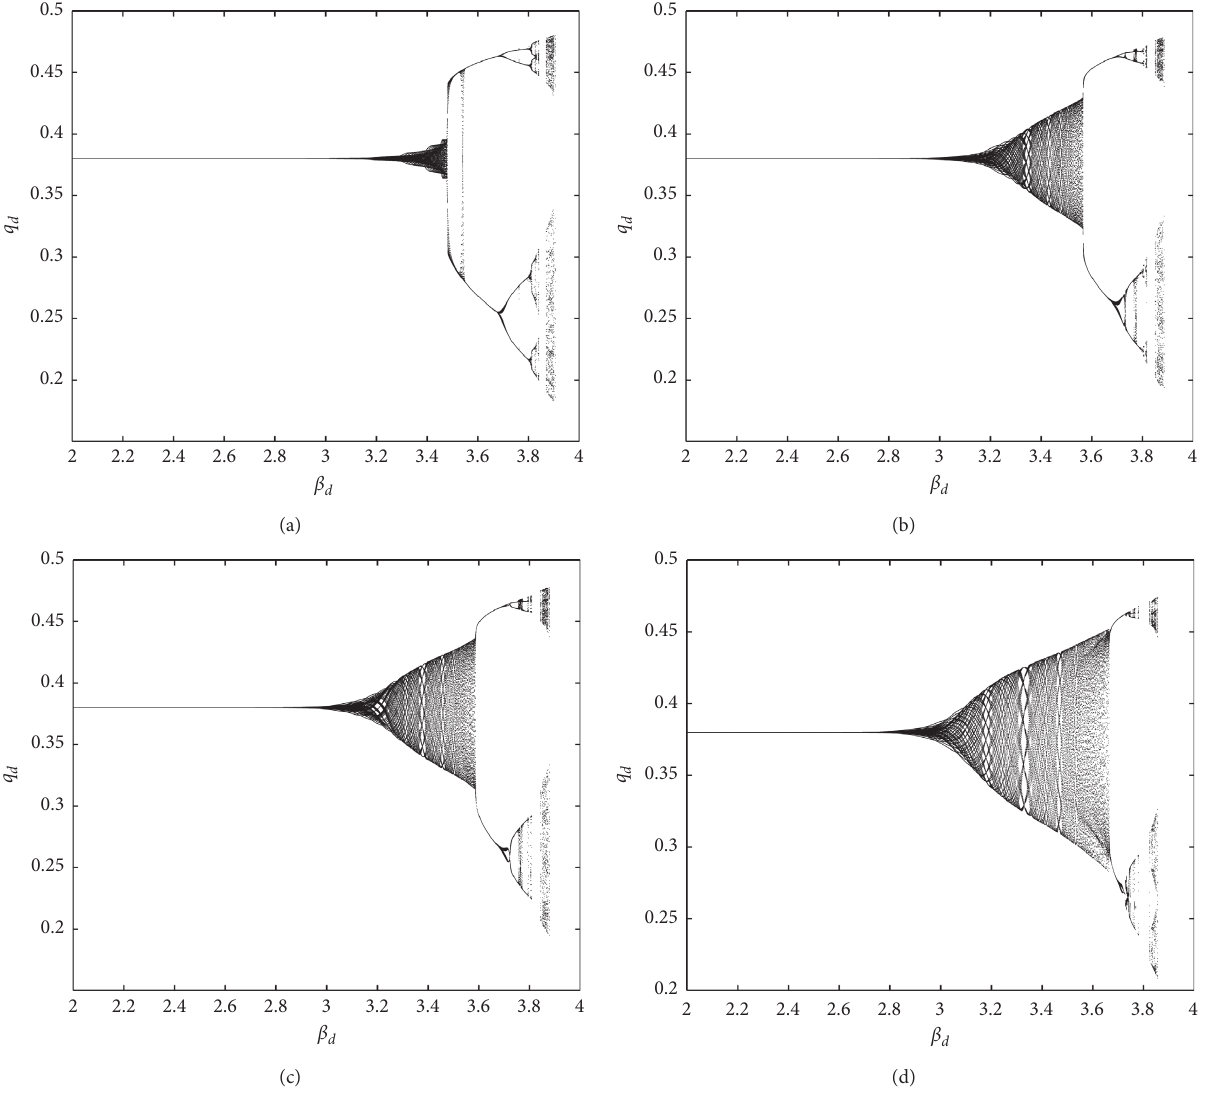
Figure 5: Bifurcation diagrams of q